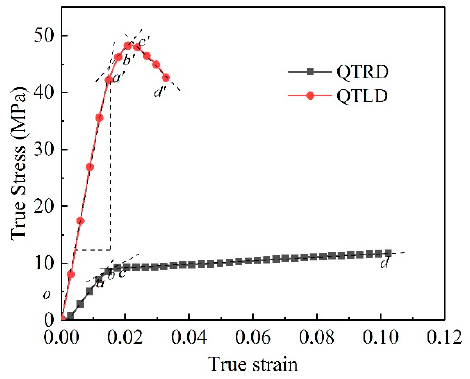
Figure 3. Typical quasi-static stress–strain curves of beech specimens in QTLD and QTRD.